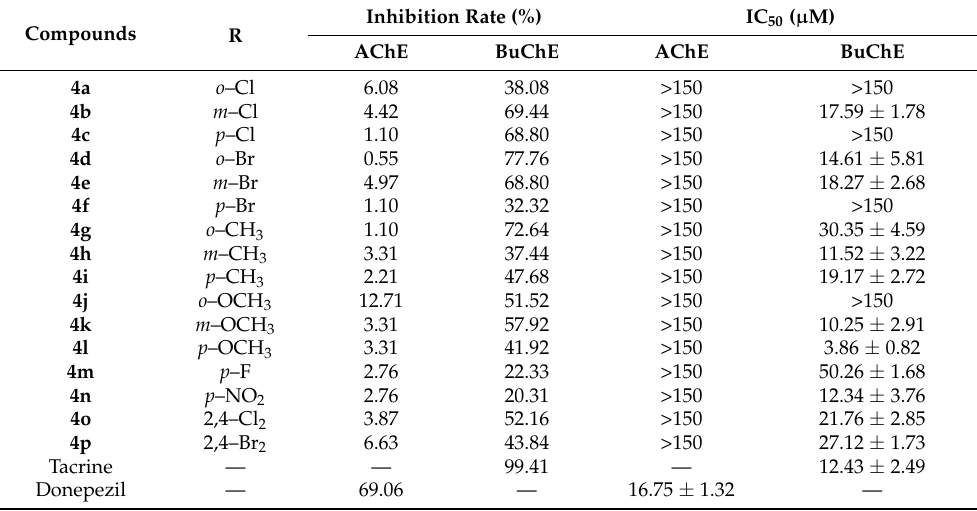
Table 3. Test results of inhibitory activity of benzothiazole–isoquinoline derivatives 4a – 4p on